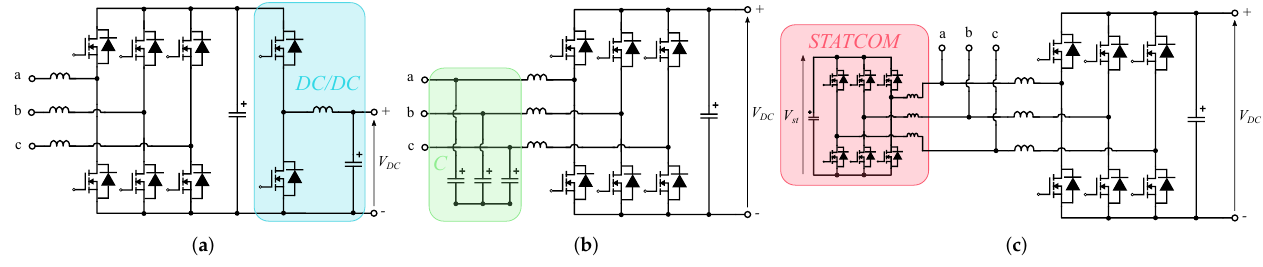
Figure 3. Schematics of the ( a ) two-stage 2L 2 and the single-stage, ( b ) 2L C , and ( c ) 2L st